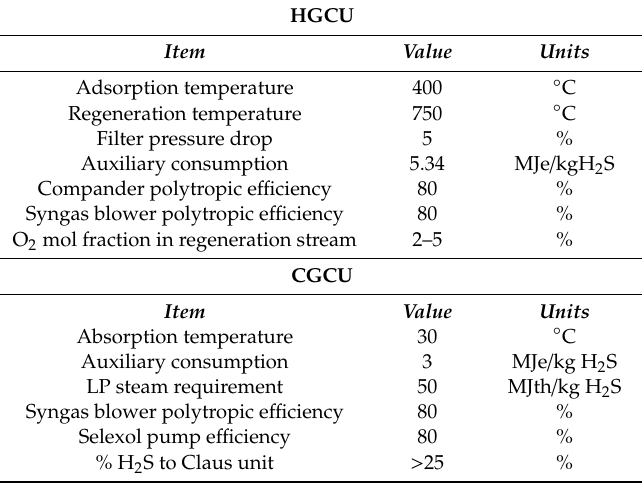
Table A2. Syngas treating unit